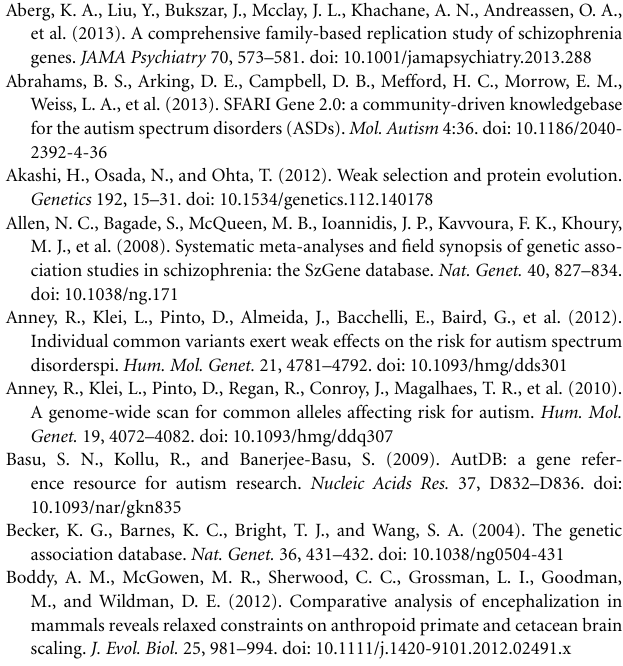
Figure S1 | Average d N /d S across taxa using subsets of the SzGR schizophrenia-associated genes. Average d N /d S of genes positively associated with schizophrenia based on associations collected in the Schizophrenia Gene Resource (SzGR), subdivided by groups by various attempts at prioritization. Pairwise significance values are shown in Supplemental Table 4. Figure S2 | Average d N /d S across taxa comparing SFARI syndromic vs. non-syndromic autism-associated genes. Average d N /d S of genes positively associated with autism based on associations collected in Simons Foundation Autism Research Initiative Gene (SFARI) subdivided into genes associated with syndromic and non-syndromic autism. Pairwise significance values are shown in Supplemental Table 5. Figure S3 | Average d N /d S across taxa comparing SFARI scored autism-associated genes. Average d N /d S of genes positively associated with autism based on associations collected in Simons Foundation Autism Research Initiative Gene (SFARI) subdivided by the scoring system used by SFARI Gene: all scored genes, genes scored with hypothesized association (5 + ), genes scored with at least minimal evidence (4 + ), and genes scored with at least suggestive evidence (3 + ). Pairwise significance values are shown in Supplemental Table